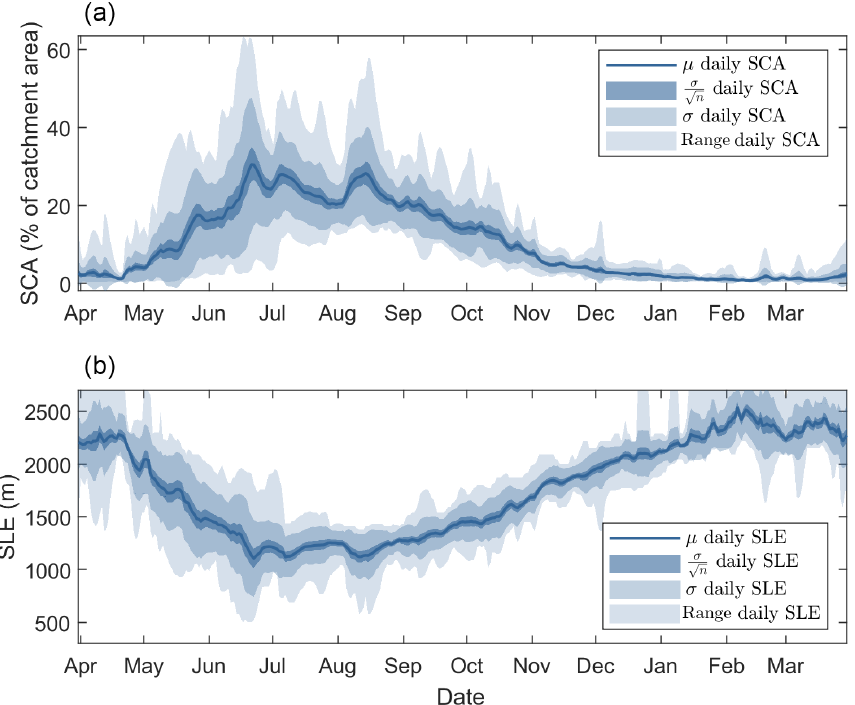
Figure 6. A 10d moving average of daily snow-covered area (SCA) (a) and snowline elevation (SLE) (b) . The mean of each is shown in black, accompanied by the envelopes of associated standard deviation and range (illustrating the spread of trajectories), as well as the standard error (representative of the uncertainty of the